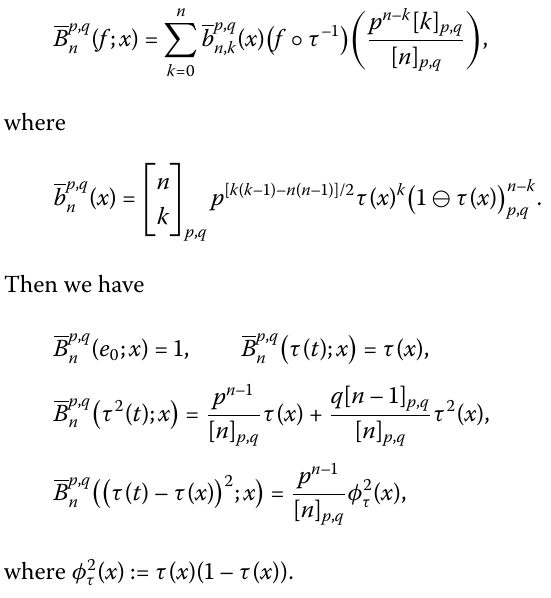
Figure 3 Approximation process by B p , q n and B p , q n